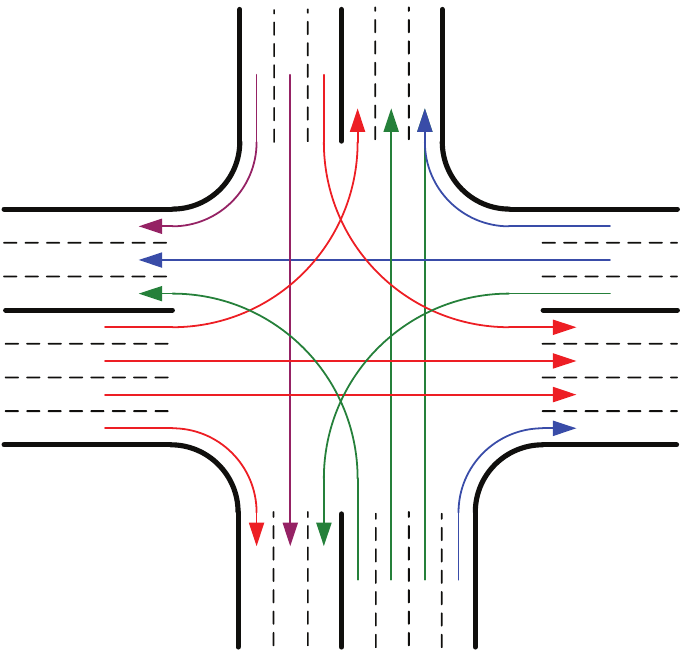
Figure 3. Paths of